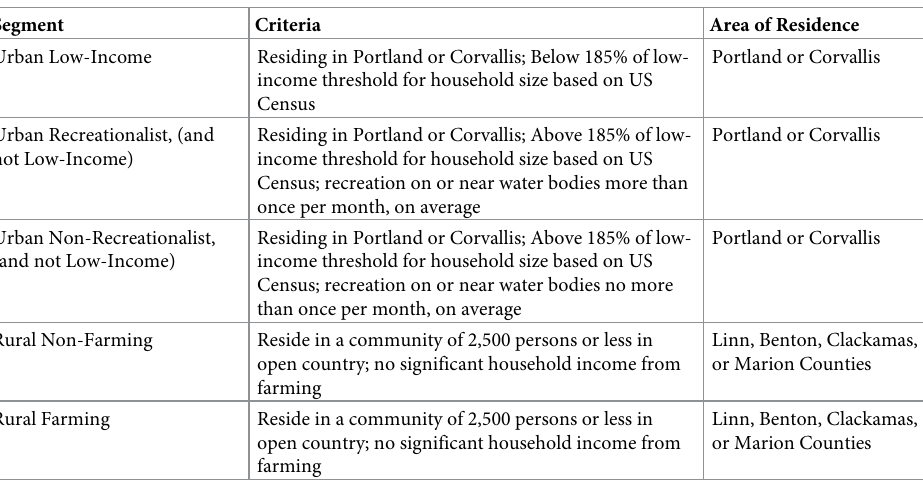
Table 1. Population segment